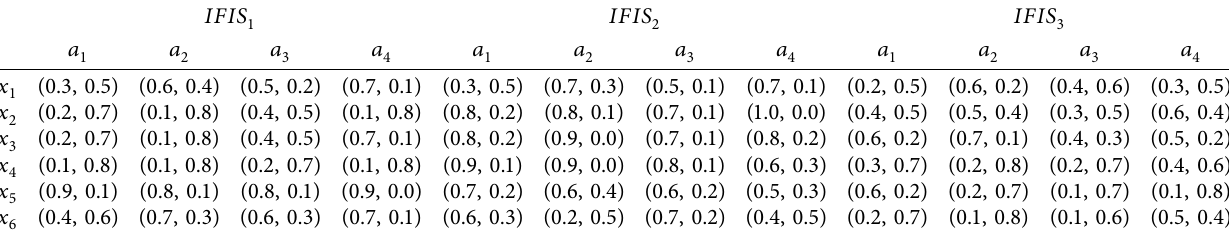
Table 2: Multisource intuitionistic fuzzy information system.